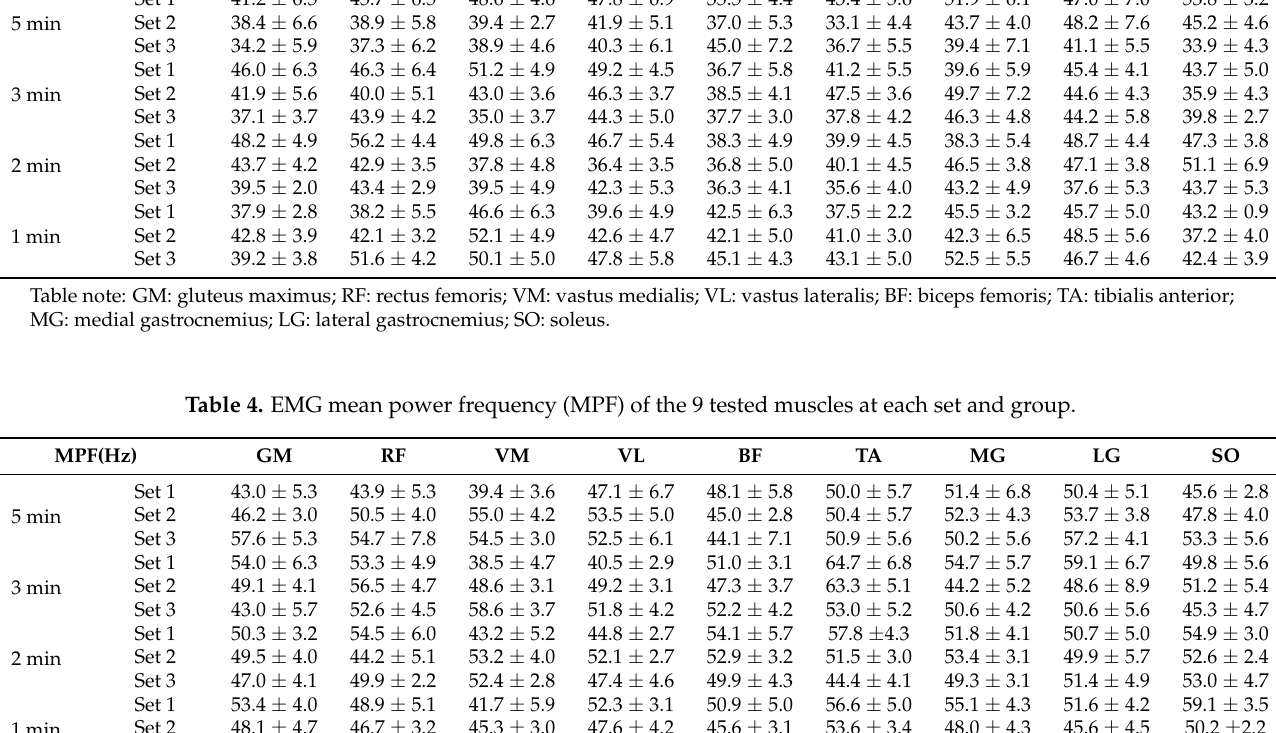
Table 3. Normalized EMG intensity for the 9 tested muscles for each set and group. Normalized Intensity (%)